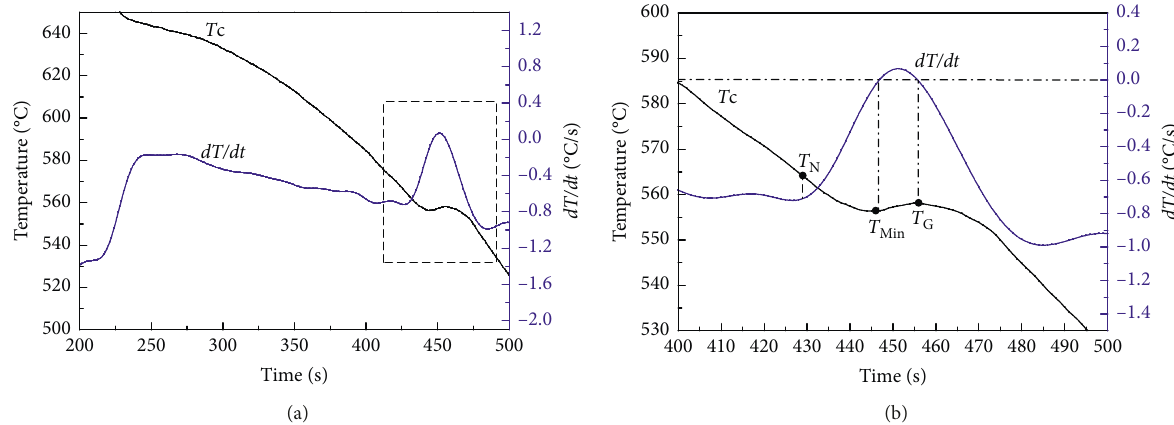
Figure 1: The cooling curve and derivative curve were used to measure the characteristic temperature of the eutectic reaction: (a) the cooling curve of (Sr+ Yb)-modified alloy with its corresponding first and second derivative curves indicating characteristic parameters and (b) the eutectic arrest is magnified, and the main characteristic temperature ( T N , T G , and T Min ) extracted from the curve are